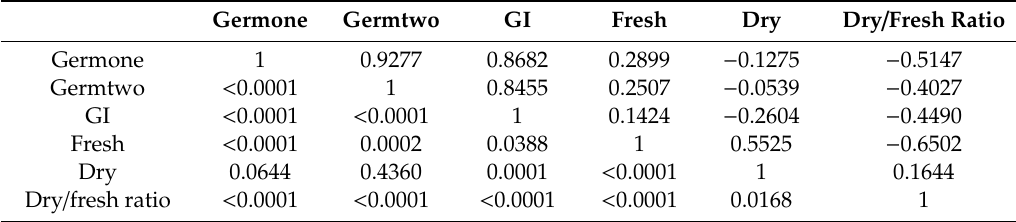
Table 3. Pearson’s correlation among six di ff erent traits under salt stress for 211 Camelina sativa